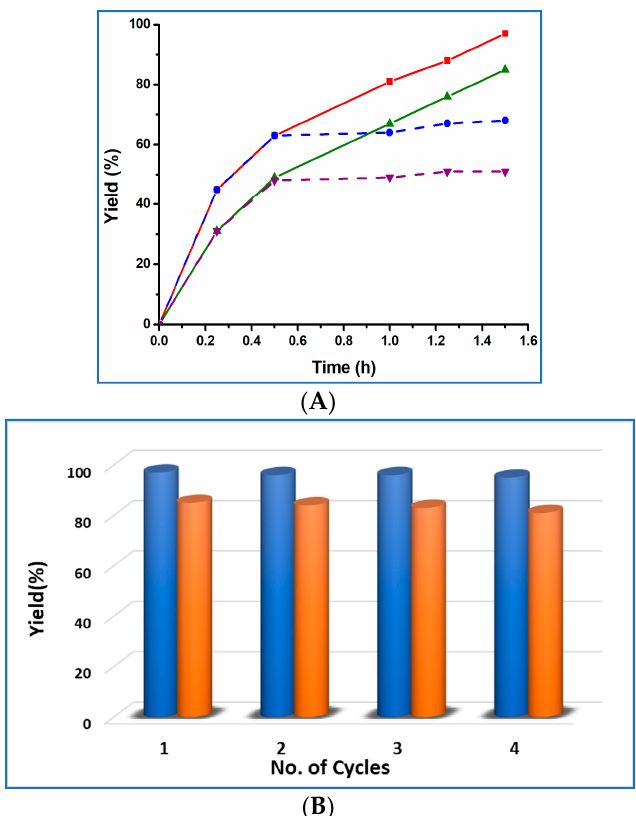
Figure 6. ( A ) Plots of product yield vs. time for the solvent-free cyanosilylation reaction, catalyzed by 1 (black line) and 2 (red line) (blue dotted line indicates the catalyst 1 removal after 0.5 h and the green dotted line concerns the catalyst 2 removal after 0.5 h). ( B ) Effect of the catalyst recycling on the final product yield (blue pillars for compound 1 and brown pillars for compound 2 ).